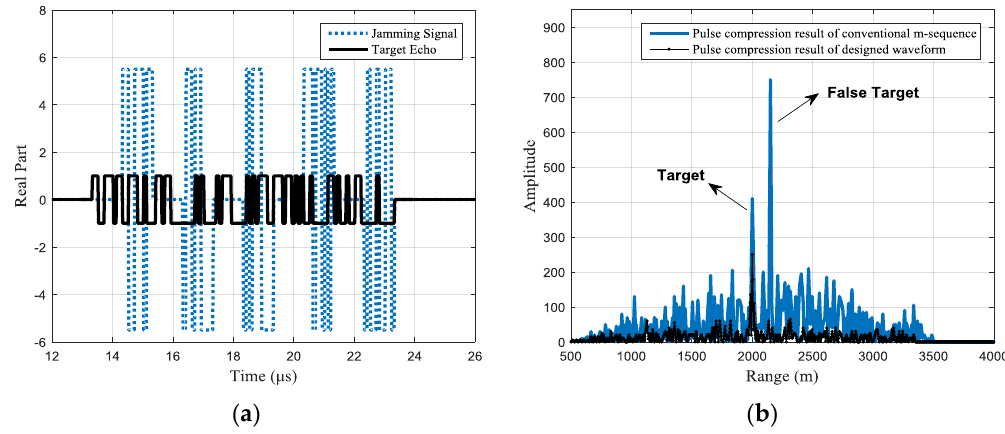
Figure 7. Jamming suppression result of a typical designed waveform (the intercepting duration is 1 μs and each jamming slice is retransmitted once): ( a ) the real part of the received signals with a typical designed waveform ( b ) pulse compression result of the received signal.